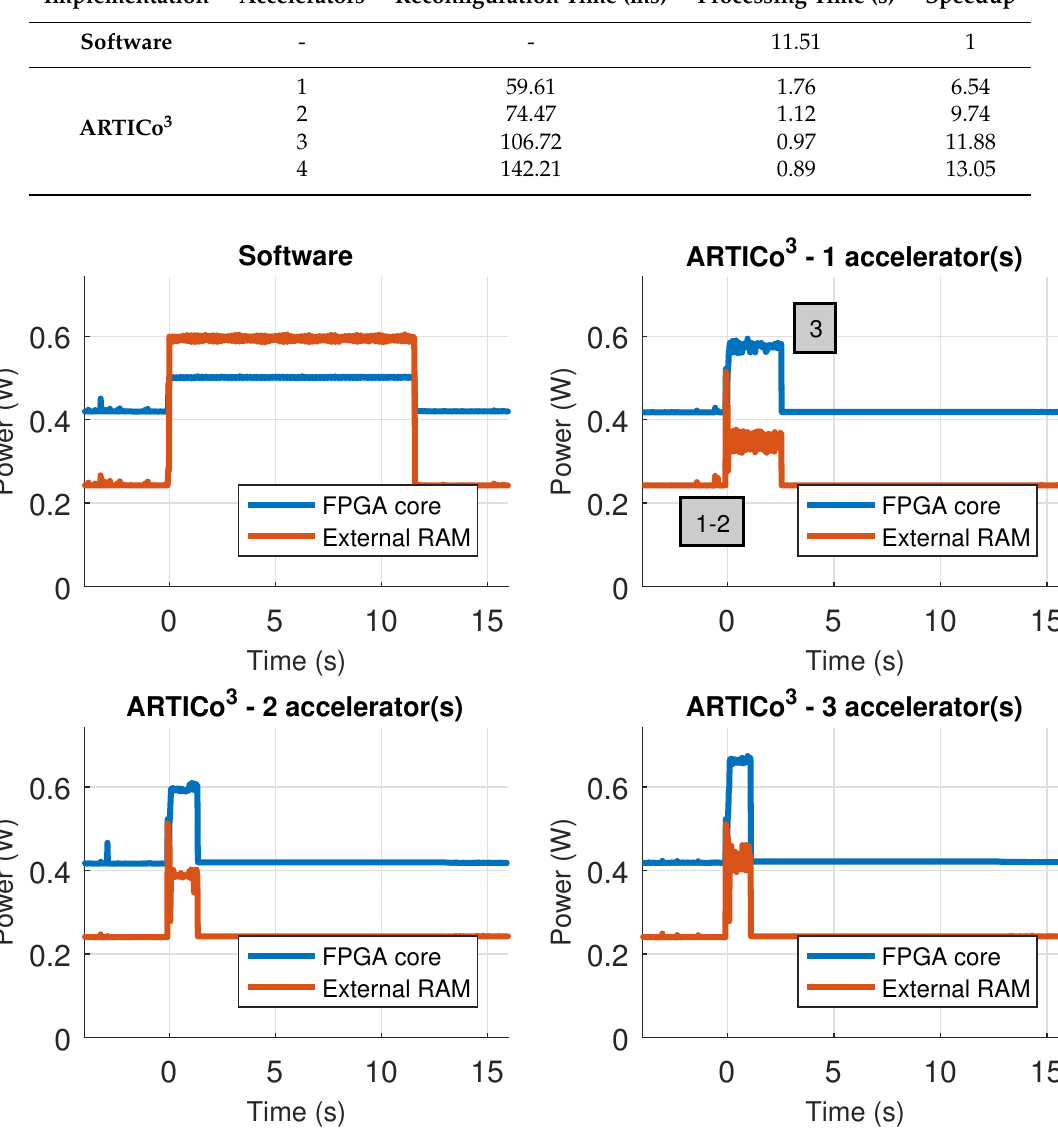
Figure 15. Power consumption profile in the Zynq-based board. Measured power rails are FPGA core and external RAM memory.